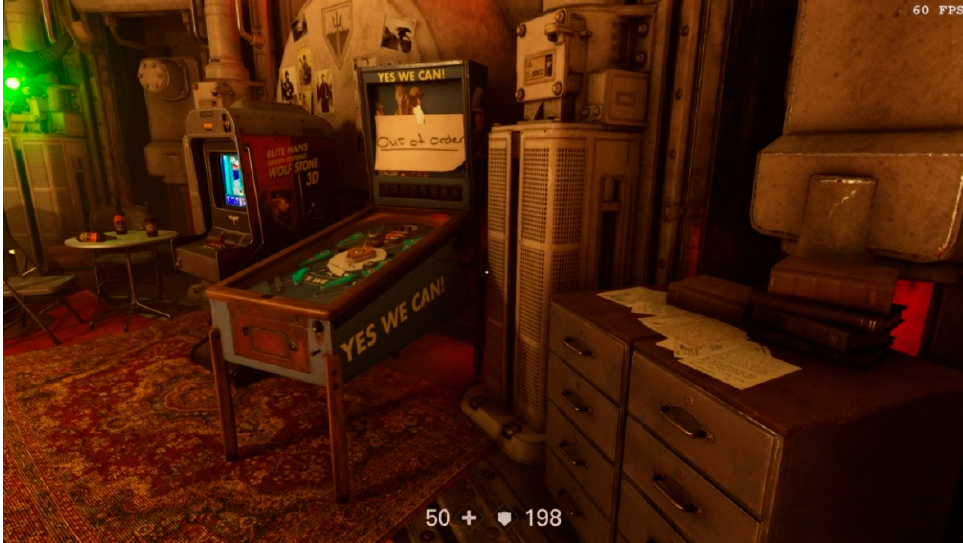
Figure 5. The in-game arcade with the “Wolfstone 3D” and “Yes We Can!” machines.